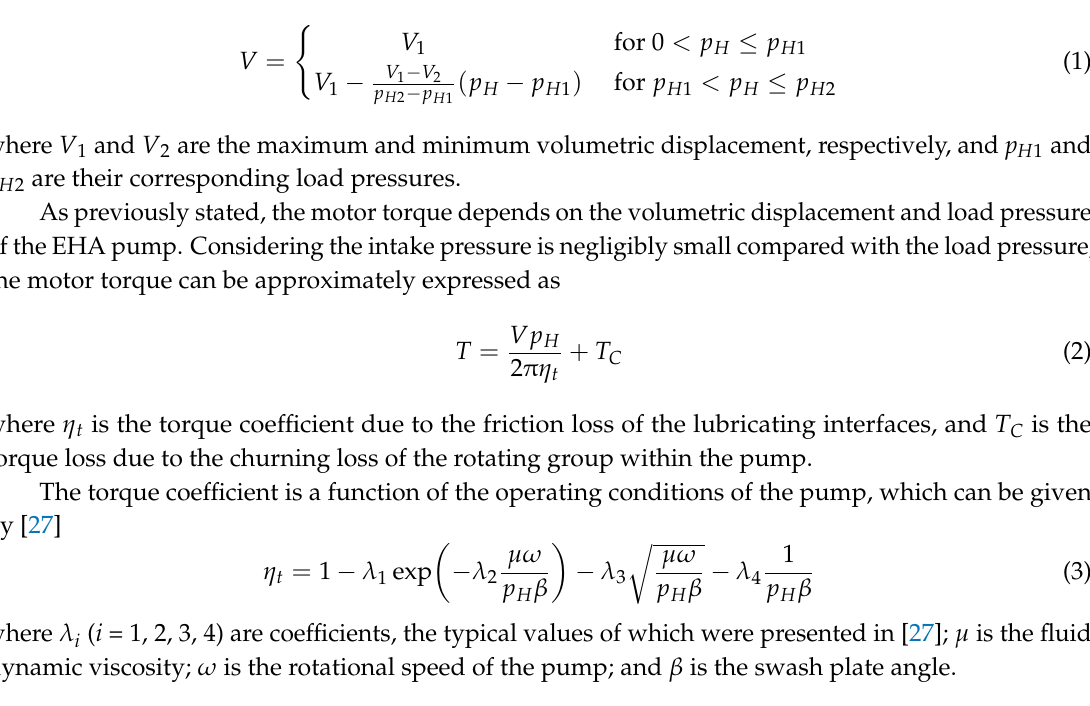
Figure 2. Relationship between load pressure and volumetric displacement or motor torque.